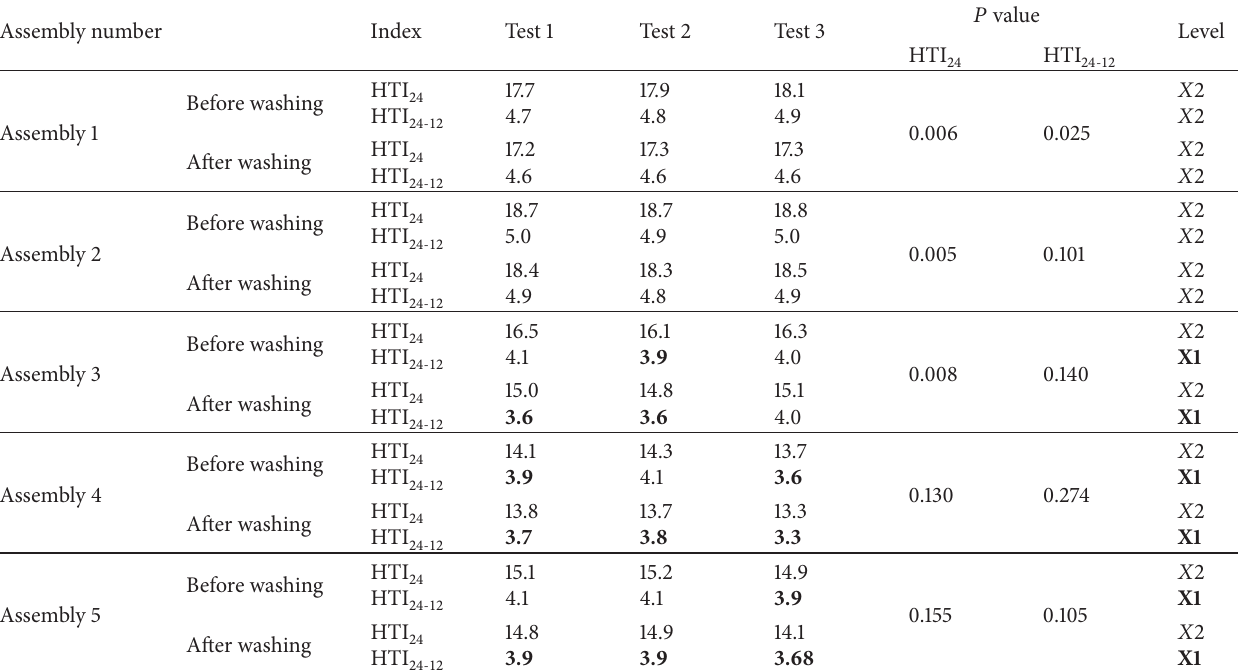
Table 4: Heat transfer-flame test results of multilayered fabric